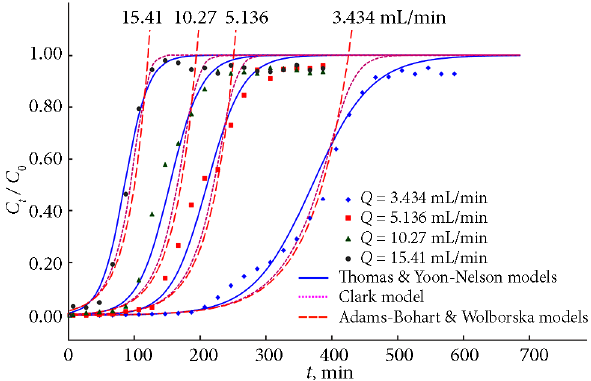
Figure 5. Effect of influent flow rate on breakthrough curve for As(V) adsorption removal by the PC-Fe/C adsorbent prepared with eucalyptus wood template (influent As(V) concentration: 20 mg/L; pH: 3; adsorbent mass: 2 g; adsorbent grain size: <100 mesh; operating temperature: 35 ° C)